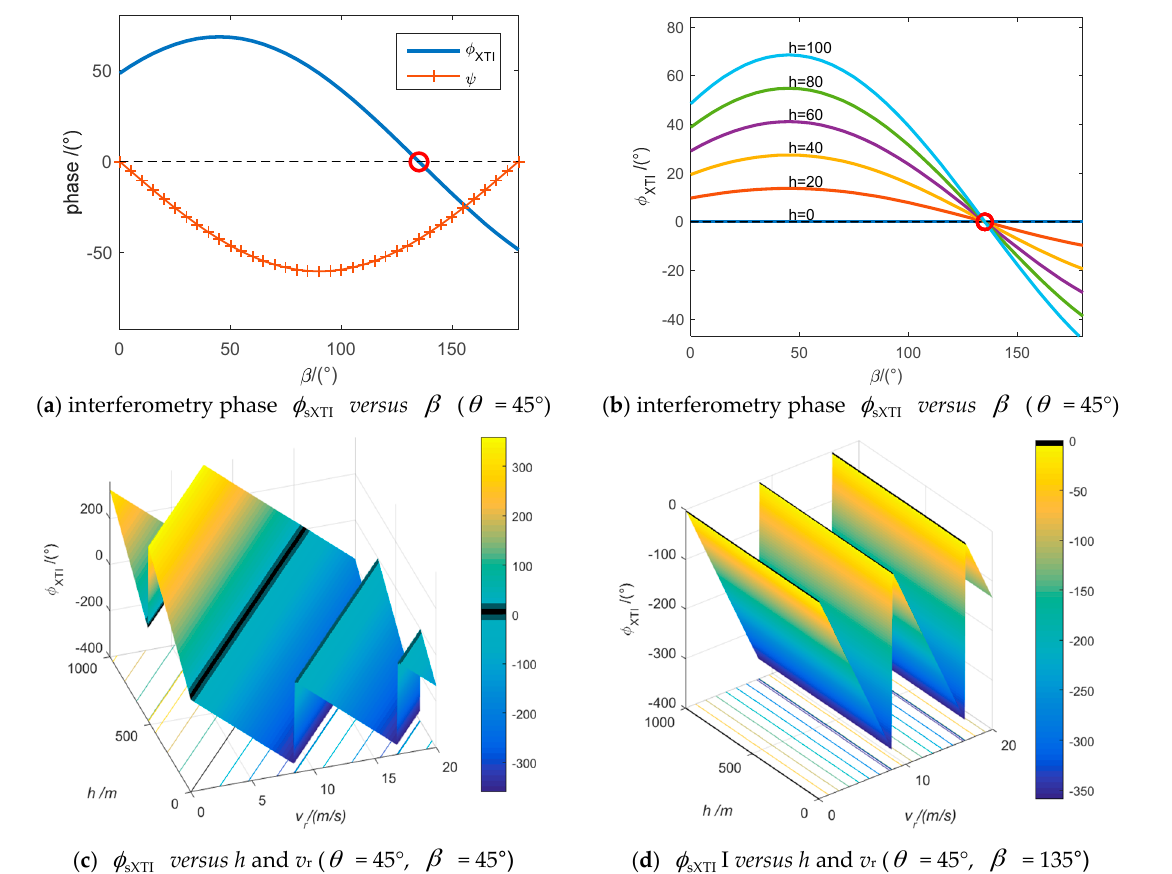
Figure 3. Squint-looking XTI-SAR interferometry phases of different baseline angles. ( a ) When h = 50 m, v r = 1 m/s and θ = 45 ˝ the interferometry phase of static target is forced zero when β = 135 ˝ , the interferometry phase with respect to target’s height is non-zero and could be used to estimate the velocity; ( b ) It is demonstrated that the interferometry phase φ XTI caused by the static targets with different height h are all forced to zeros when β = 180 ´ θ ; ( c ) When θ = 45 ˝ and β = 45 ˝ , i.e. , sin p θ ` β q ‰ 0, the interferometry phase φ XTI is jointly decided by terrain height and target radial velocity; ( d ) When θ = 45 ˝ and β = 135 ˝ , i.e. , sin p θ ` β q “ 0, the interferometry phase φ XTI is constant regardless of height h and it is linearly varied with target’s radial velocity v r . That is, the interferometry phase will be linearly related to the target’s radial velocity v r .